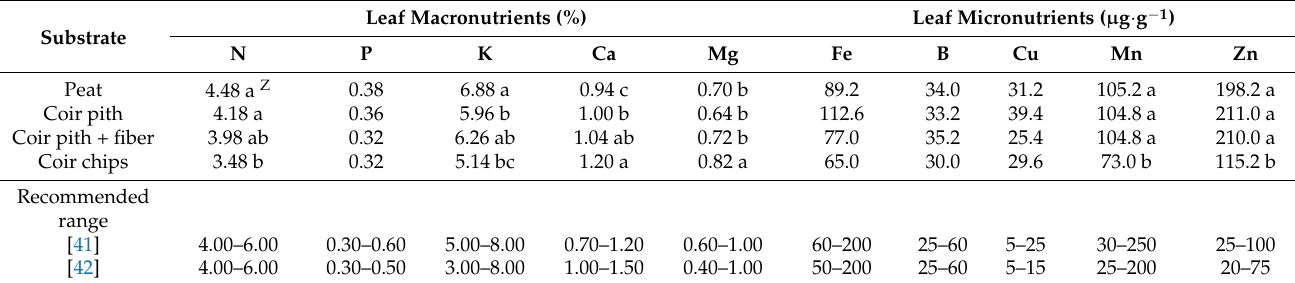
Table 2. Nutrient concentration in fully expanded spinach